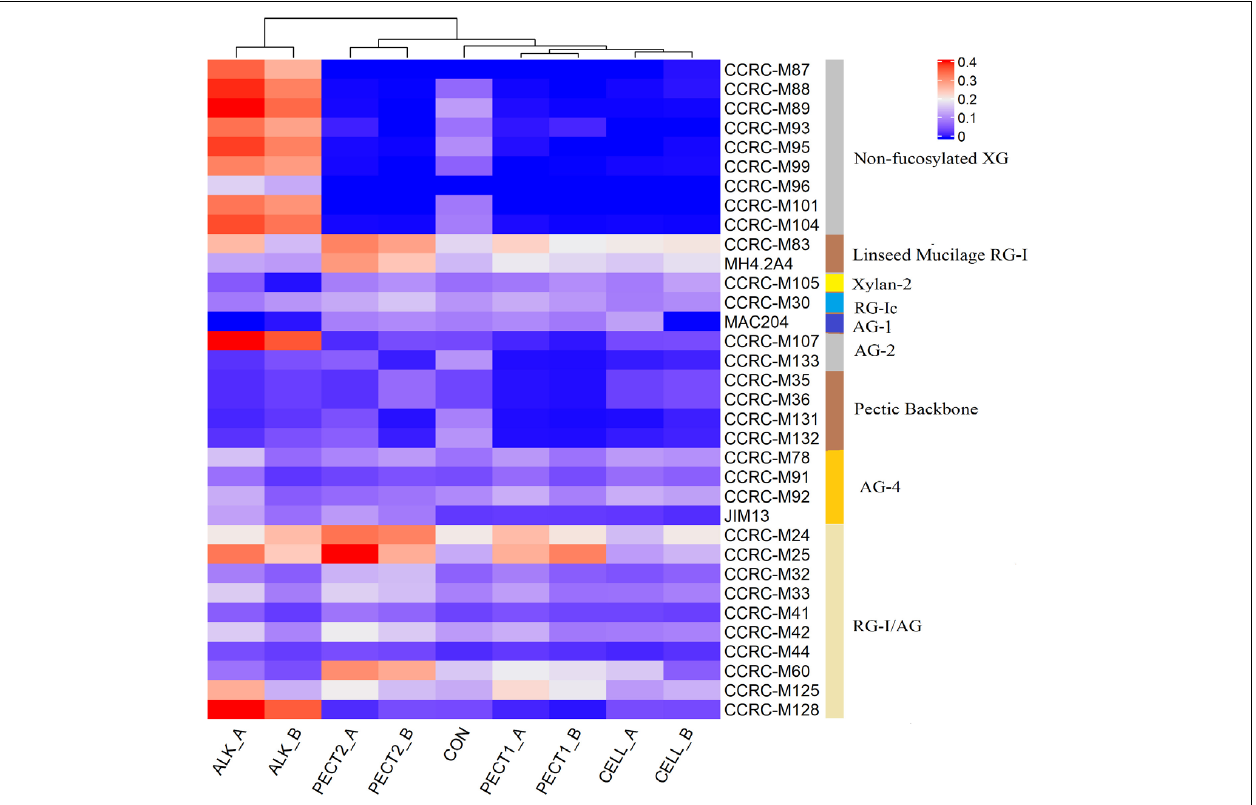
FIGURE 2 | Glycome profiling of non-processed and processed RSM. The binding response data of the mAbs are presented as heatmap using a blue-white-red scale indicating the intensity of the ELISA signal (blue, white, and red colors depict no, medium, and strong binding, respectively). The mAbs (indicated by their codes) are grouped based on the cell wall glycans they predominantly recognize as shown in the panel on right-hand side of the figure. _A, RSM was treated after predigestion, _B; RSM was treated before predigestion. XG, xyloglucan; RG-I, rhamnogalacturonan I; AG, arabinogalactan; RG-I/AG, arabinogalactan side chains of